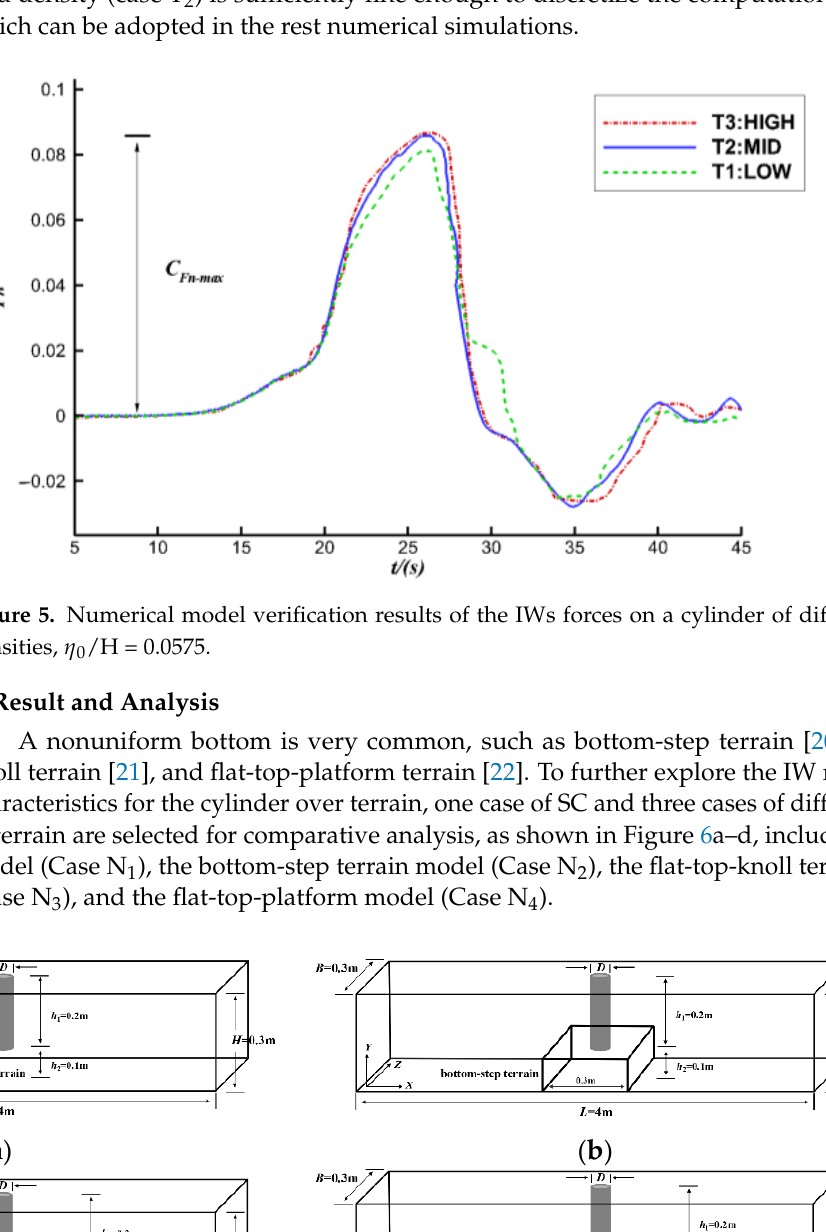
1 , ( b ) N 2 , ( c ) N 3 , ( d ) N 4